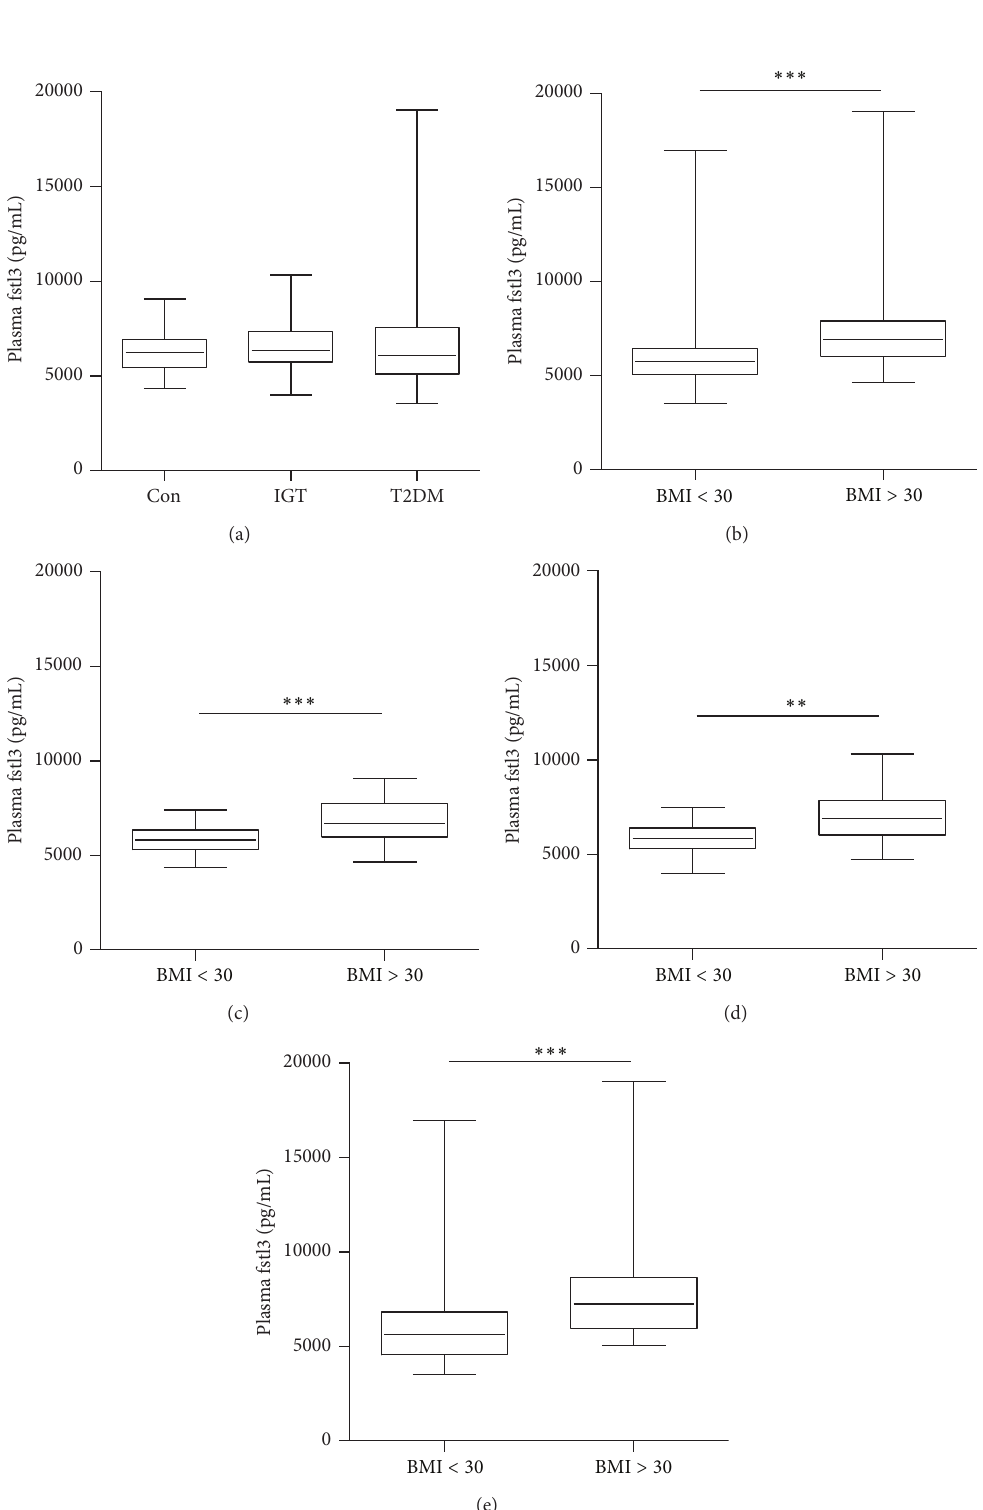
Figure 1: Plasma follistatin-like 3 in subjects with different glucose tolerance and in nonobese and obese subjects. (a) Plasma follistatin-like 3 (fstl3) subdivided by glycemic status (CON, 𝑛 = 78 ), impaired glucose tolerance (IGT, 𝑛 = 58 ), and patients with type 2 diabetes (T2DM, 𝑛 = 64 ). (b) Plasma fstl3 in obese ( 𝑛 = 97 ) and nonobese subjects ( 𝑛 = 103 ). (c) Subdividing the control (obese = 36; nonobese = 42), (d) the impaired glucose tolerant (obese = 39; nonobese = 19), and (e) patients with type 2 diabetes (obese = 28; nonobese = 36). Boxplot showing median value of plasma fstl3 with 25th and 75th quartiles whiskers represents maximum and minimum value of fstl3. ∗∗ indicates 𝑃 < 0.01 . ∗∗∗ indicates 𝑃 < 0.001